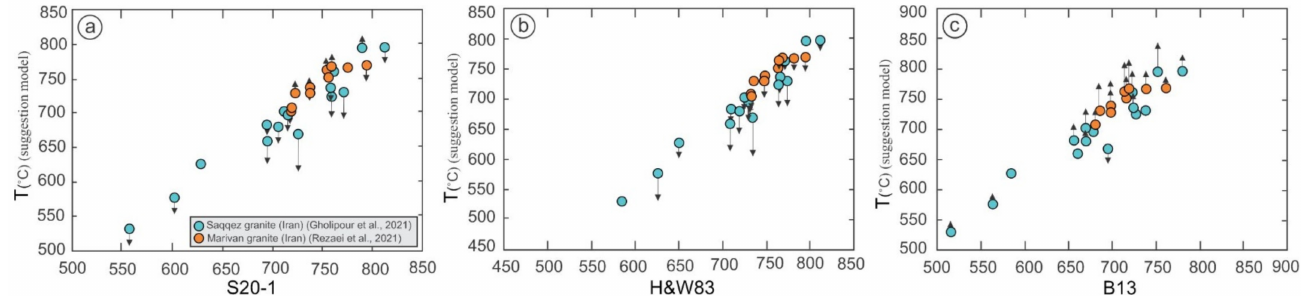
Figure 13. The correlation of the present suggested model temperature with the previously published equations ( a ) S20-1 [36], ( b ) W&H83 [18], and ( c ) B13 [19] for some metaluminous to peraluminous igneous rocks [69,70]. That shows the HFSEs in bulk rocks chemistry have a clear relation to the magma crystallization temperature and it is more consistent with zircon saturation temperature at higher than 750 ◦ C. The length of the arrow shows the differences in the suggested temperature here with T(S20-1), W&H83, and B13,